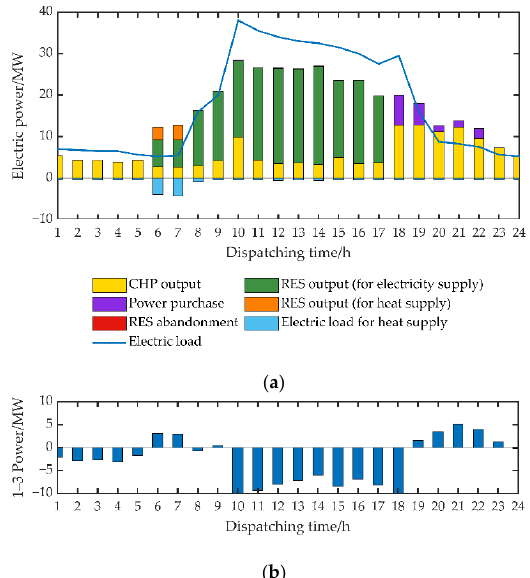
Figure 13. Dispatching strategy of the office area under joint dispatching: ( a ) Electric power of the office area; ( b ) Electric power of the tie line. The joint dispatching of the industrial area is shown in Figure 14. In the condition of joint dispatching, the RES abandonment and the amount of purchased electricity are sig- nificantly reduced. The power output is smaller than the power load as a result of receiv- ing the electricity transmitted from the residential area from 8:00–17:00.